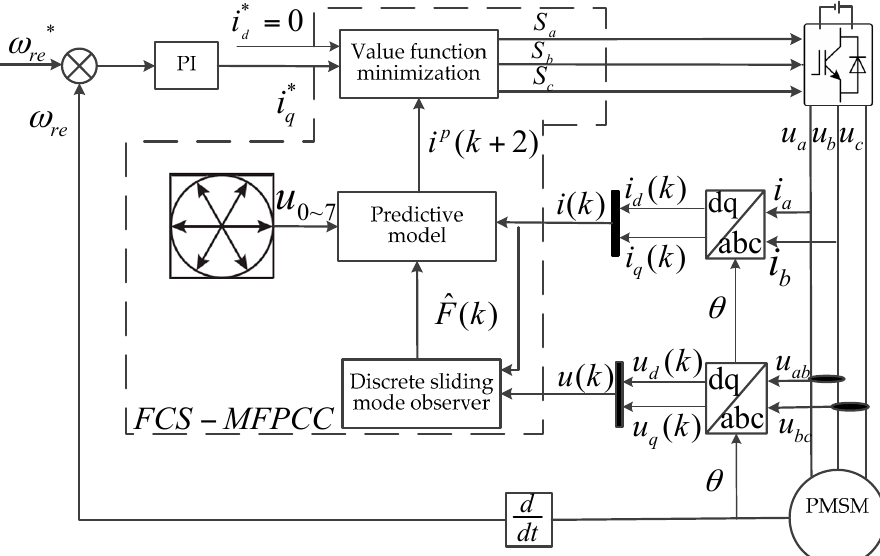
Figure 4. Block diagram of FCS-MPFCC.